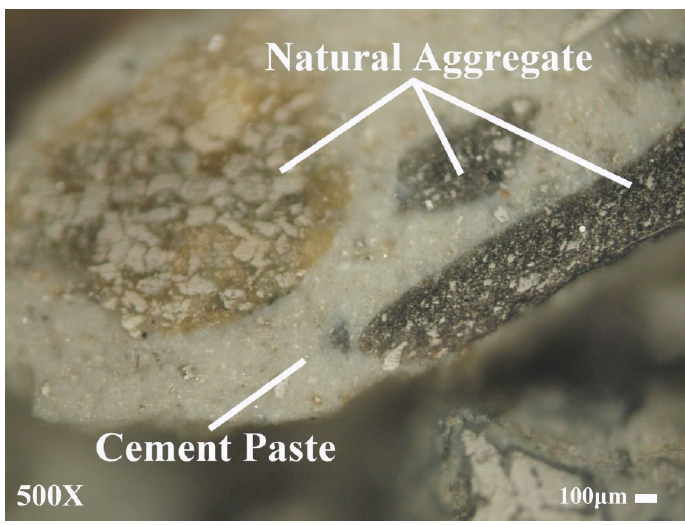
Figure 4. Microscopic observation of fine recycled concrete